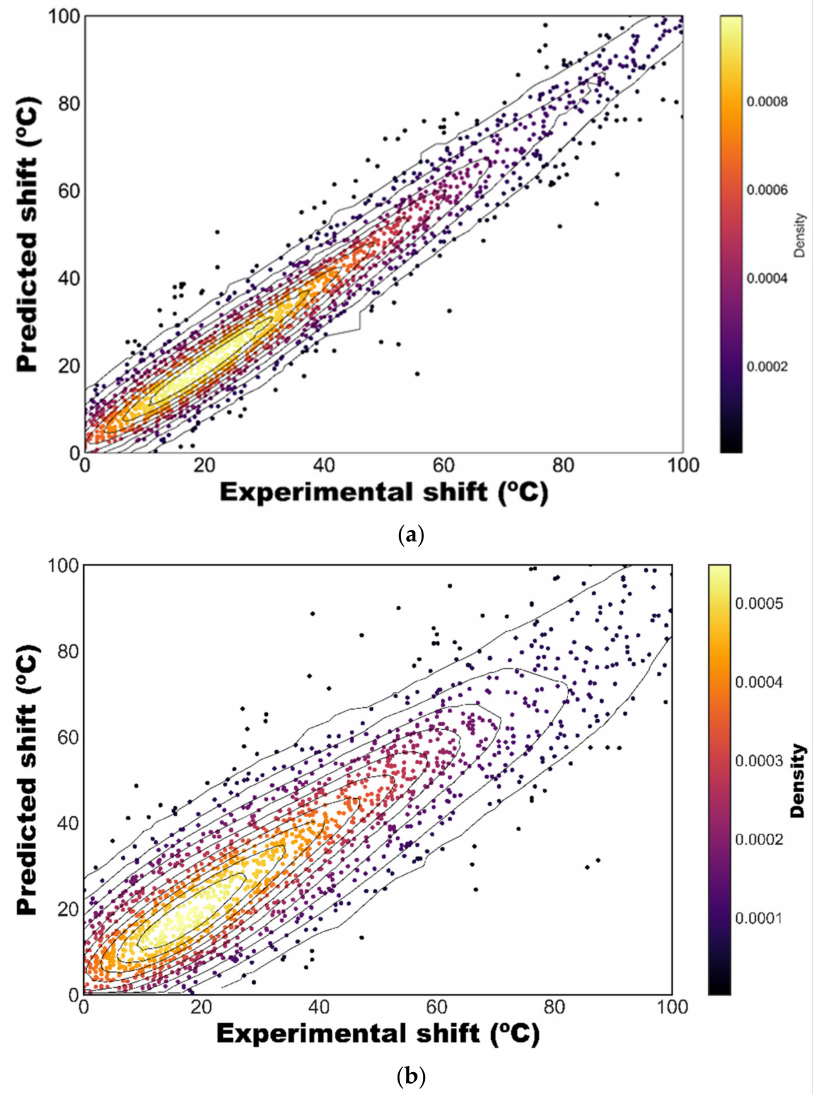
Figure 9. Scatterplot relating the experimental and predicted TTS. ( a ) Gradient Boosting, ( b ) ASTM E900-15